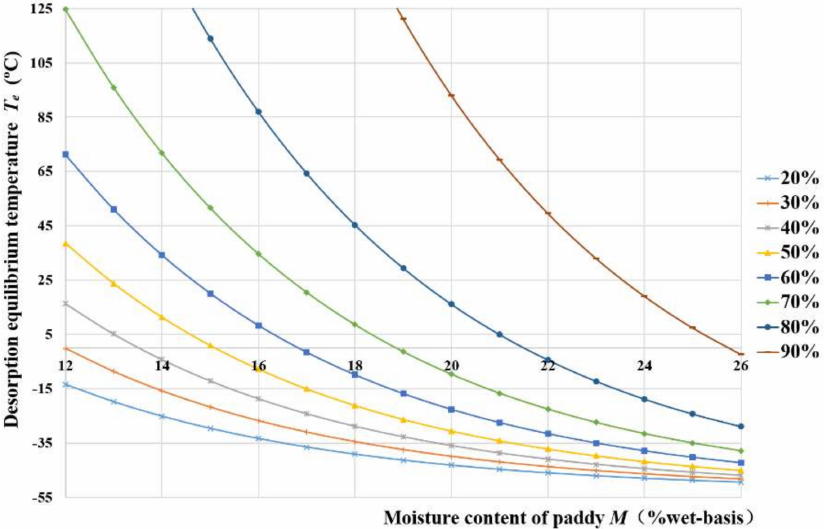
Figure 1. Relationship between the moisture content of rice and the desorption equilibrium tempera- ture under different relative